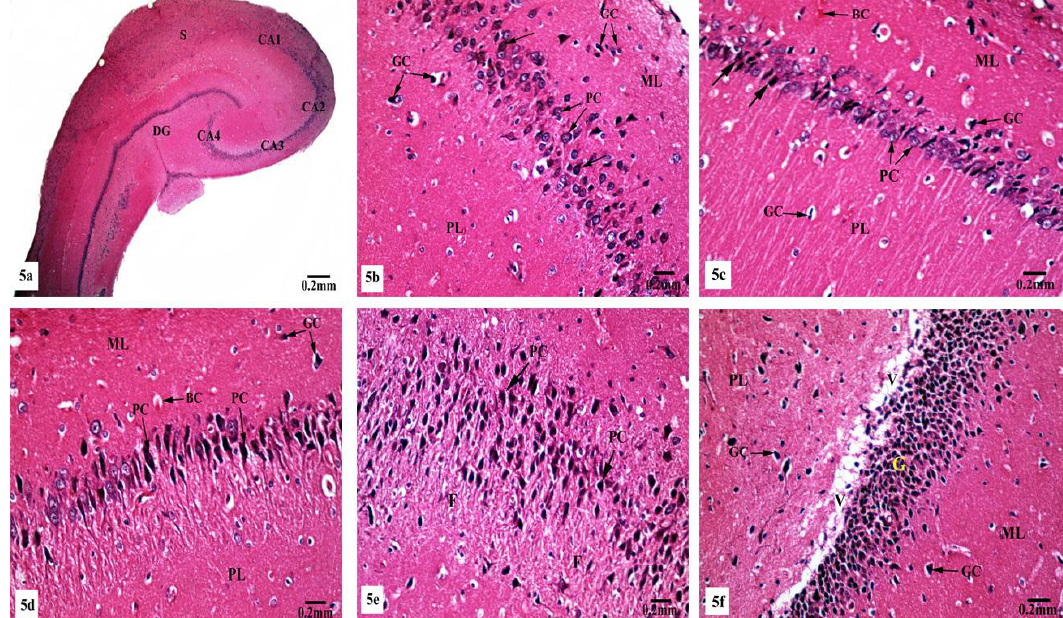
Figure 5. Photomicrographs of the hippocampal tissues of AlCl 3 -treated rats stained with Hx&E showing ( a ) disruption of normal laminar organization, where the hippocampus appeared flattened, formed of CA1, CA2, CA3, and CA4 subfields, DG, and subiculum (S); ( b ) the CA1 subfield had disorganized small pyramidal cells (PC) and some of them appeared shrunken with pyknotic nuclei ( → ). Some glial cells (GC) appeared enlarged in the molecular (ML) and polymorphic (PL) layers; ( c ) another CA1 zone revealed marked shrunken small pyramidal cells (PC) and some of them showed pyknosis ( → ). Dilated congested blood capillaries (BC) and glial cells (GC) were also seen; ( d ) the CA3 subfield revealed large pyramidal cells (PC) exhibiting shrinkage with pyknotic nuclei, moreover, enlarged glial cells (GC) and dilated blood capillaries (BC) were noticed; ( e ) disorganized large pyramidal cells (PC) having pyknotic nuclei, in addition to fibrosis (F) were clearly seen in the surrounding neuropil in another CA3 area; ( f ) the granular cell layer (G) of the DG showed marked vacuolation (V). Molecular (ML) and polymorphic (PL) layers showed marked enlarged glial cells